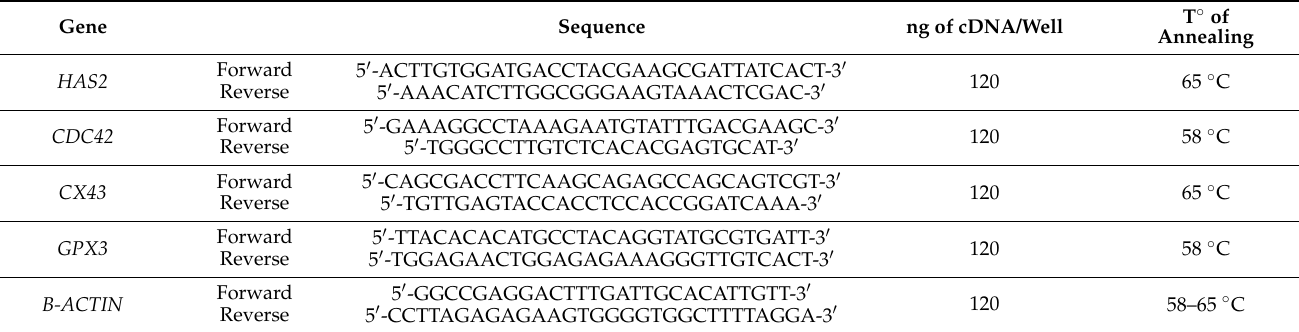
Table 2. Sequences of the primers and real-time PCR conditions used in this